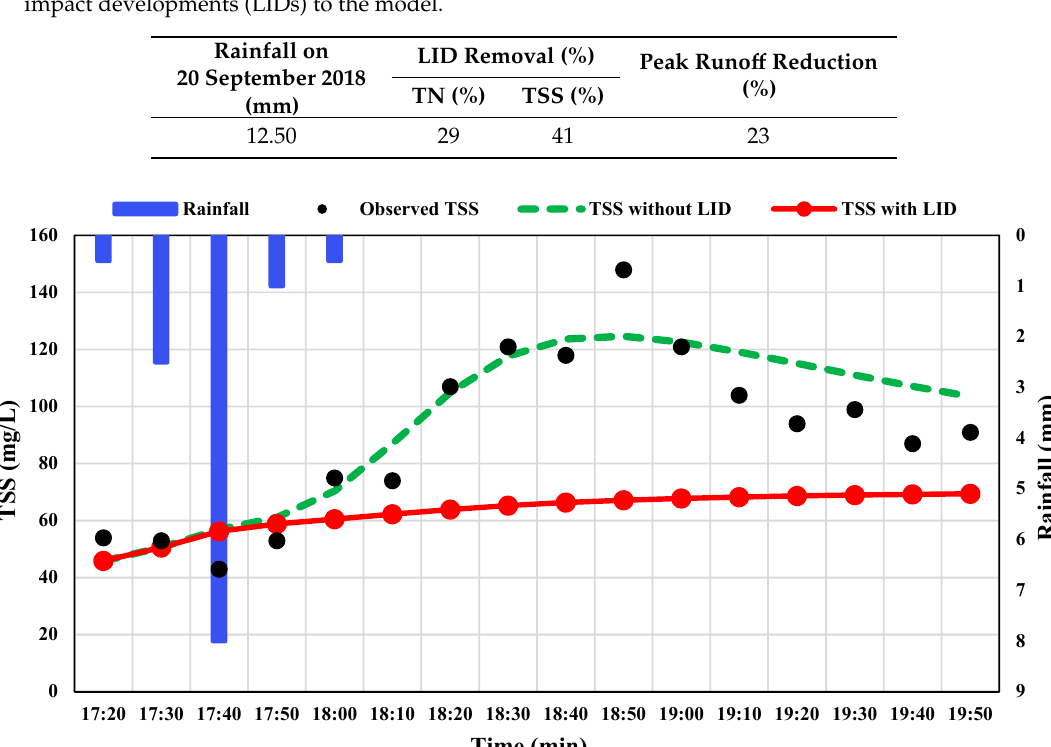
Figure 9. TSS reduction after assigning LIDs to the model.